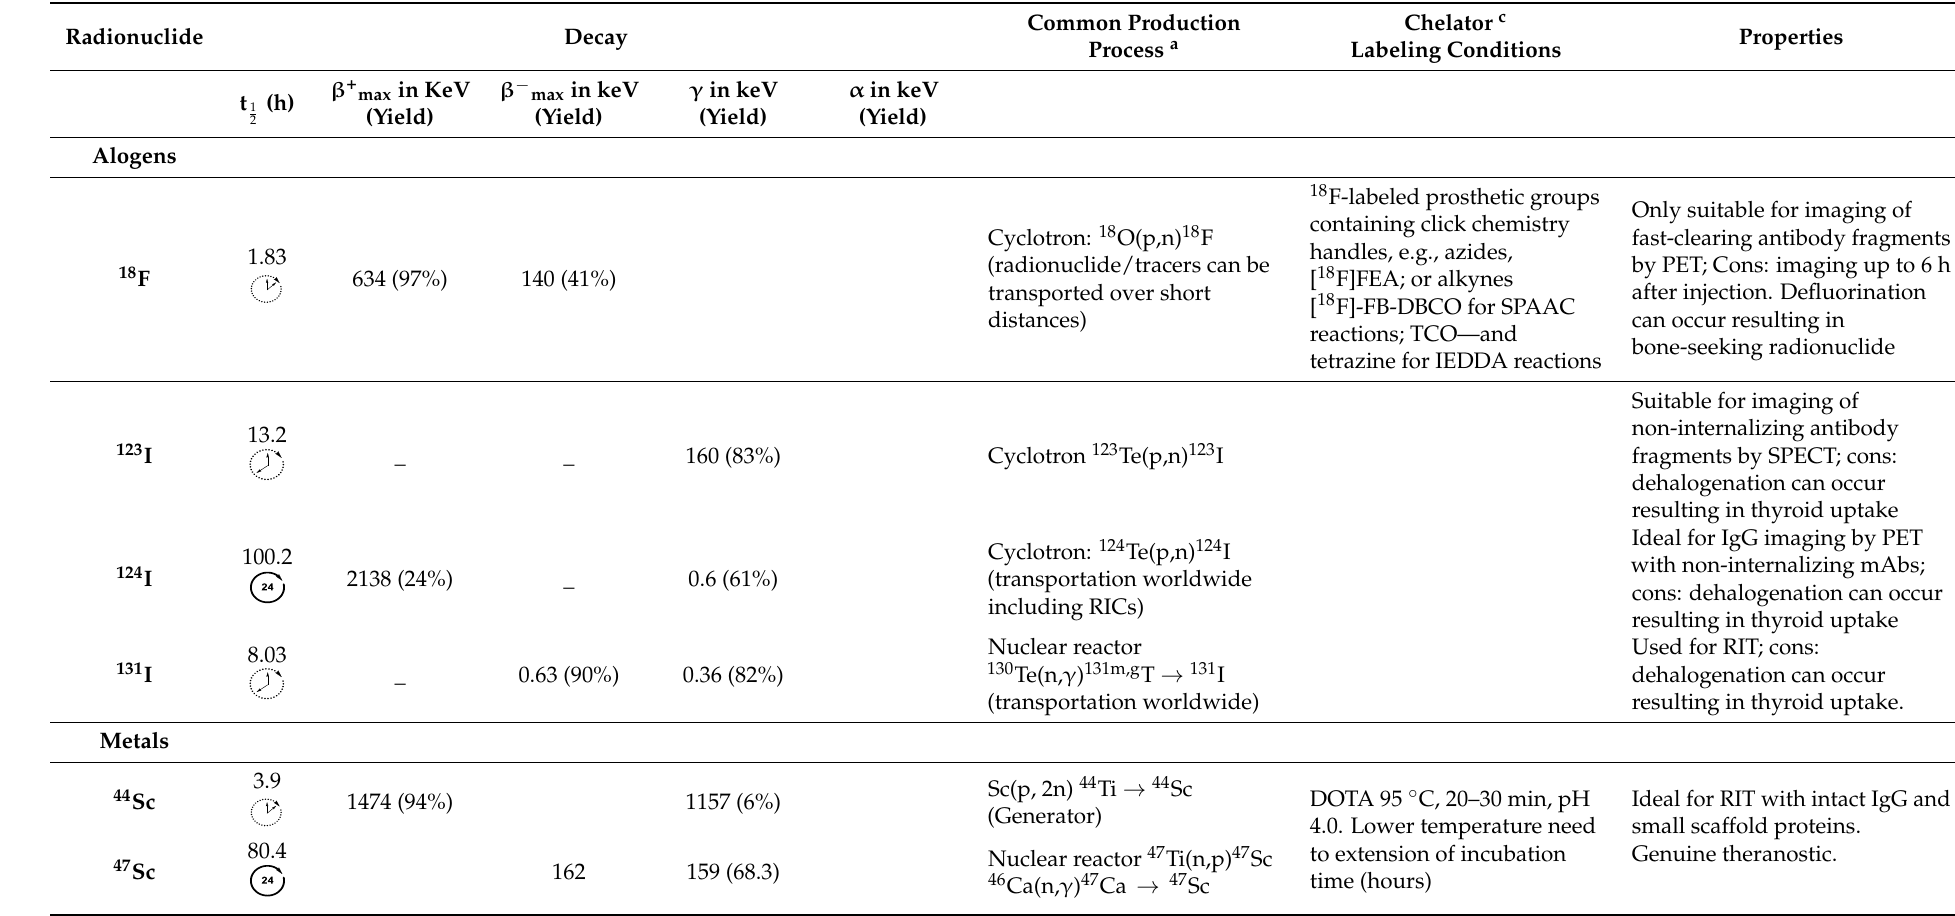
Table 2. Radionuclides used in radioimmunoconjugates for PET, SPECT, and radioimmunotherapy (RIT) .